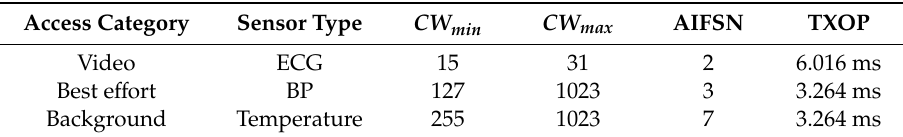
Table 2. Revived EDCF